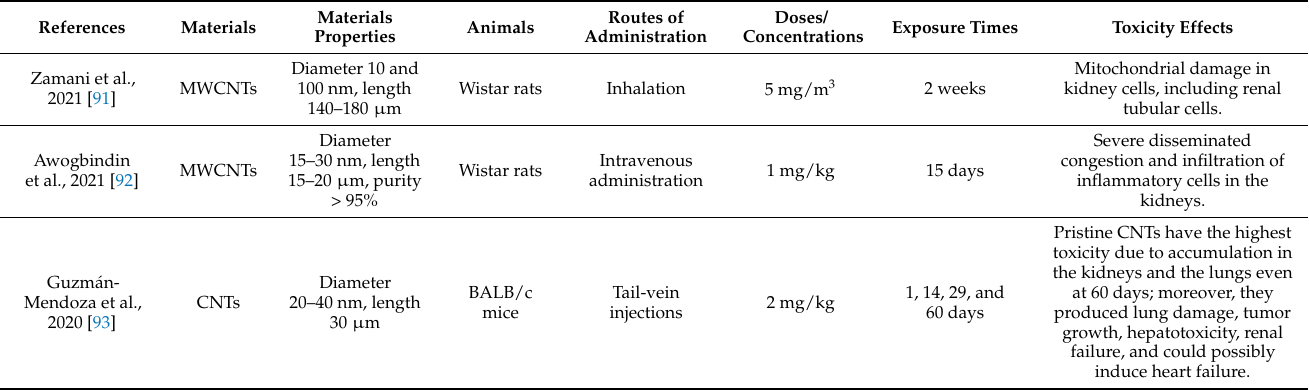
Table 3. Nephrotoxicity of pristine carbon nanotubes using rodents as animal